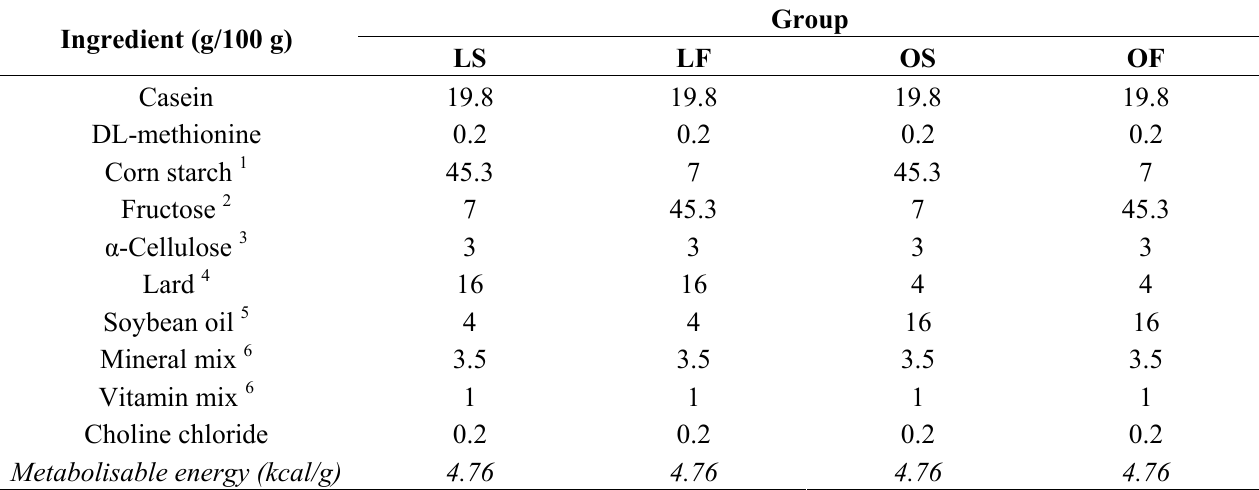
Table 1. Composition of the diets fed to the